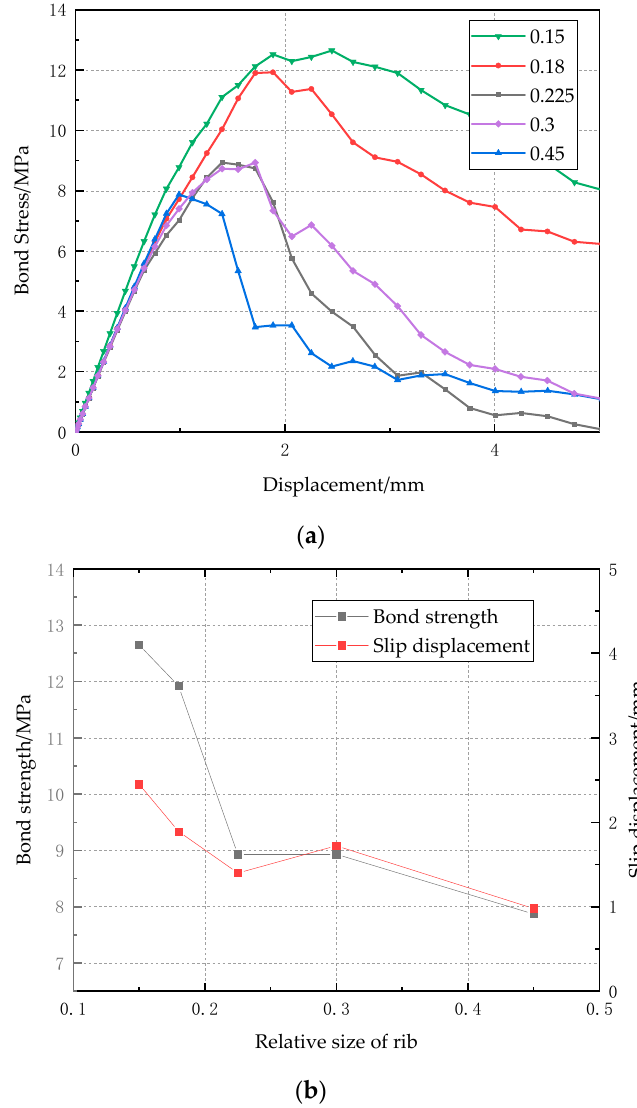
Figure 11. Effect of relative size of rib on bond strength ( a ) bond-clip curves ( b ) relationship between bond strength/slip displacement and relative size of rib.